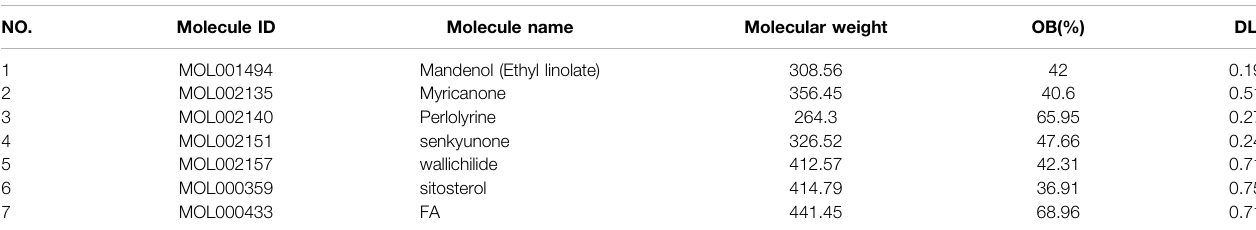
TABLE 1 | The ADME characteristics of CX active compounds according to the TCMSP database.